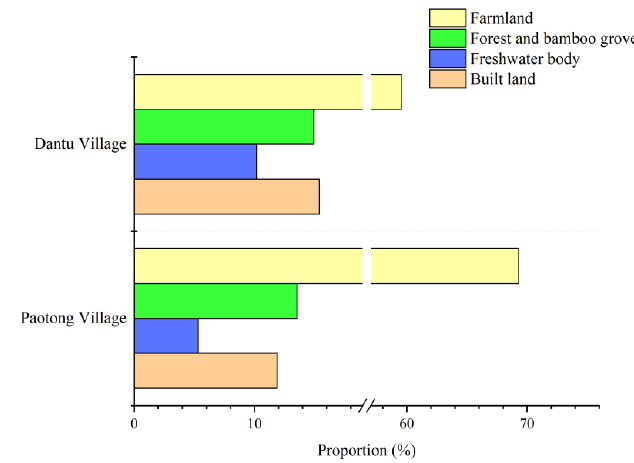
Figure 2. The Proportion of land cover in two case-study sites.